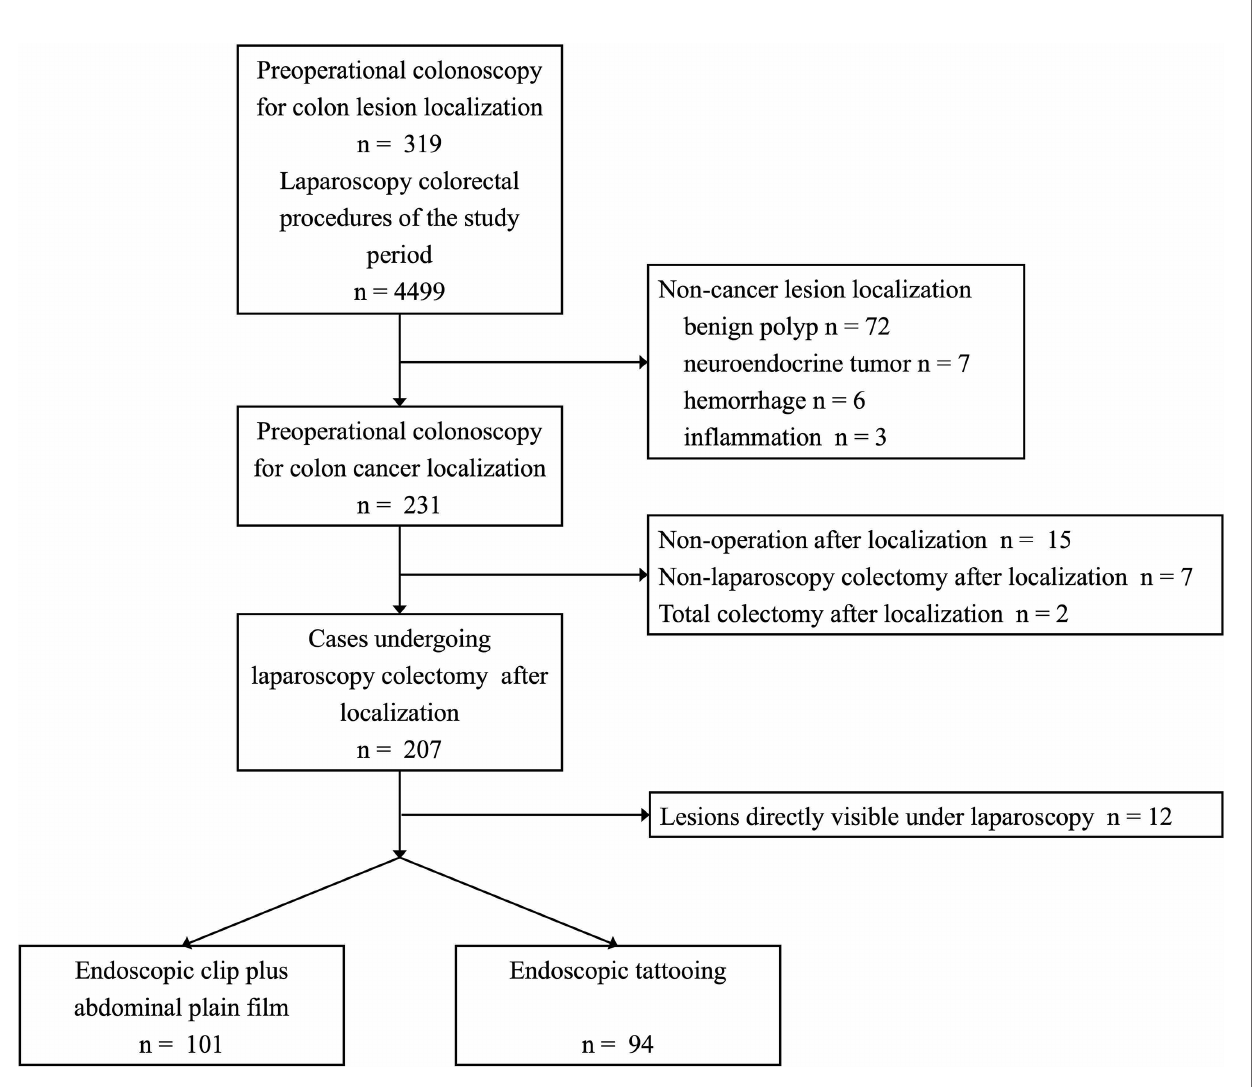
FIGURE 1 | The fl owchart of patient